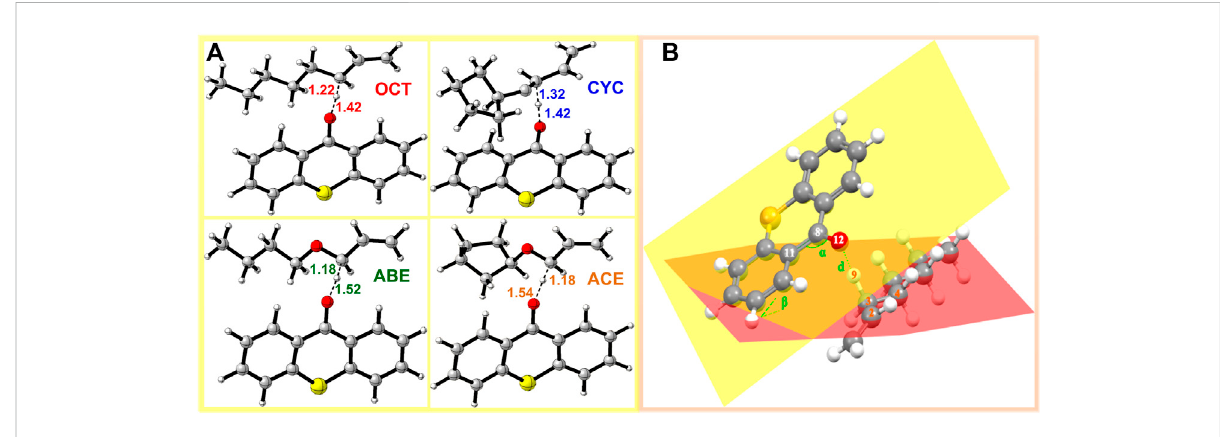
FIGURE 4 TSstructureinHATreactions: (A) structureofallylmonomersandallylethermonomercomplexesoptimizedatthelevelofB3LYP/6-311++G(d, p) (The dotted lines represent virtual σ bonds, and the unit is Å); (B) schematic view of the